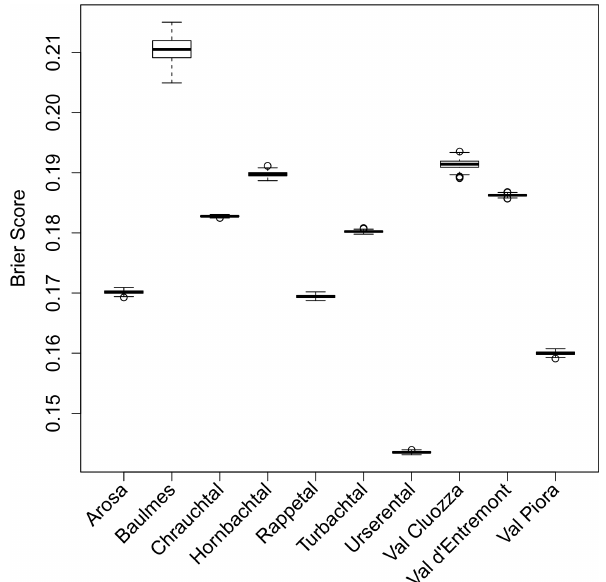
Figure 9. Performance measure expressed with the Brier score for the models for all 10 sites. Plot shows boxplots of Brier scores, where lower Brier scores are indicative of better model perfor- mance.